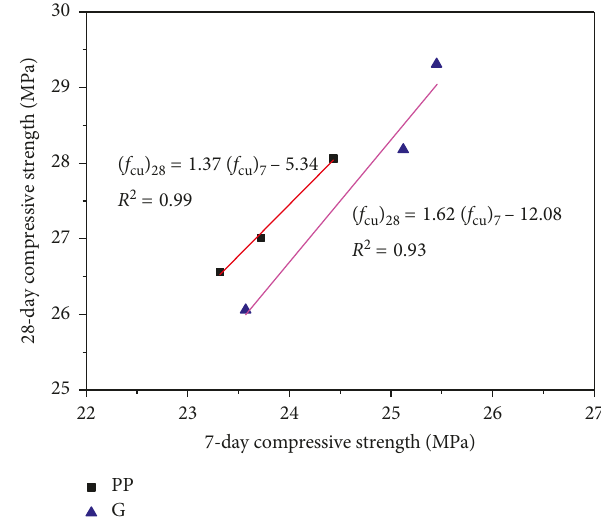
Figure 6: Relationship between 3-day and 28-day compressive strengths.